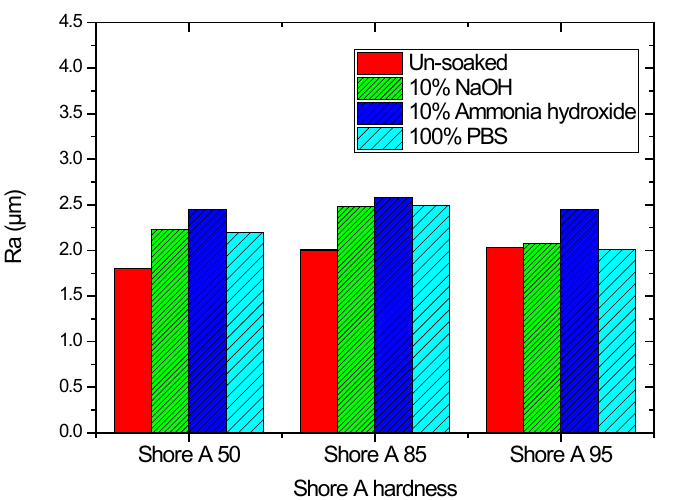
Figure 7. Surface SEM morphologies of the substrate with a Shore A hardness of 95: ( a ) without and ( b ) with Parylene C coating.